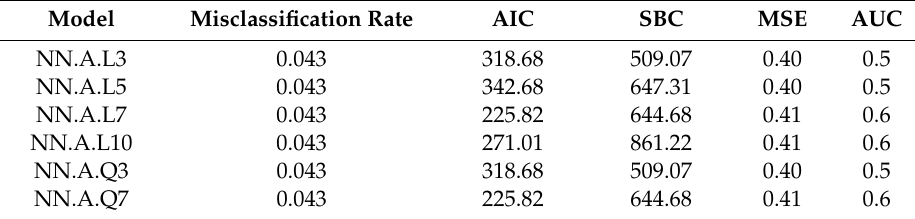
Table 14. Second comparison of neural network models.